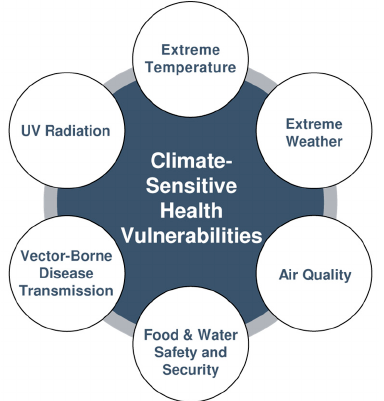
Figure 2. Identified climate-sensitive health vulnerability categories of importance for Simcoe Muskoka, adapted from Health Canada [2].